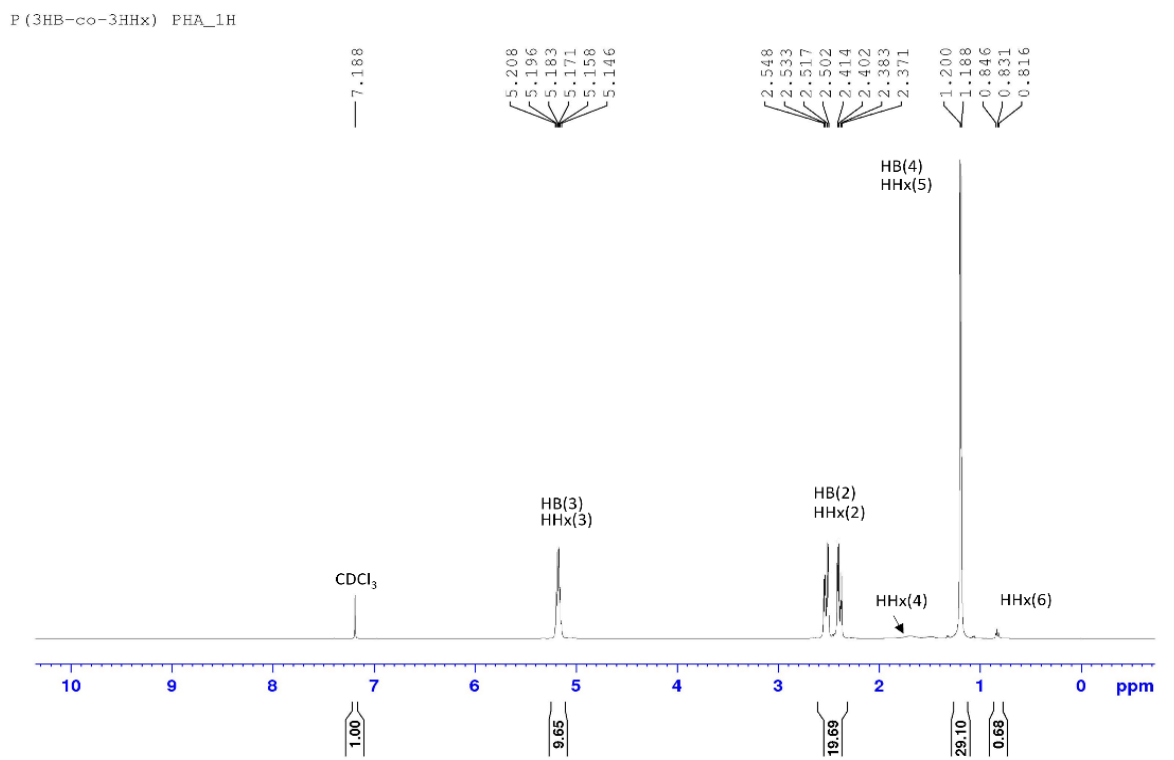
Figure 3. Proton Nuclear Magnetic Resonance Spectroscopy ( 1 H NMR) spectrum of P(3HB ‐ co ‐ 2 mol% 3HHx) produced by C. necator PHB − 4/pBBR_CnPro ‐ phaC Rp .